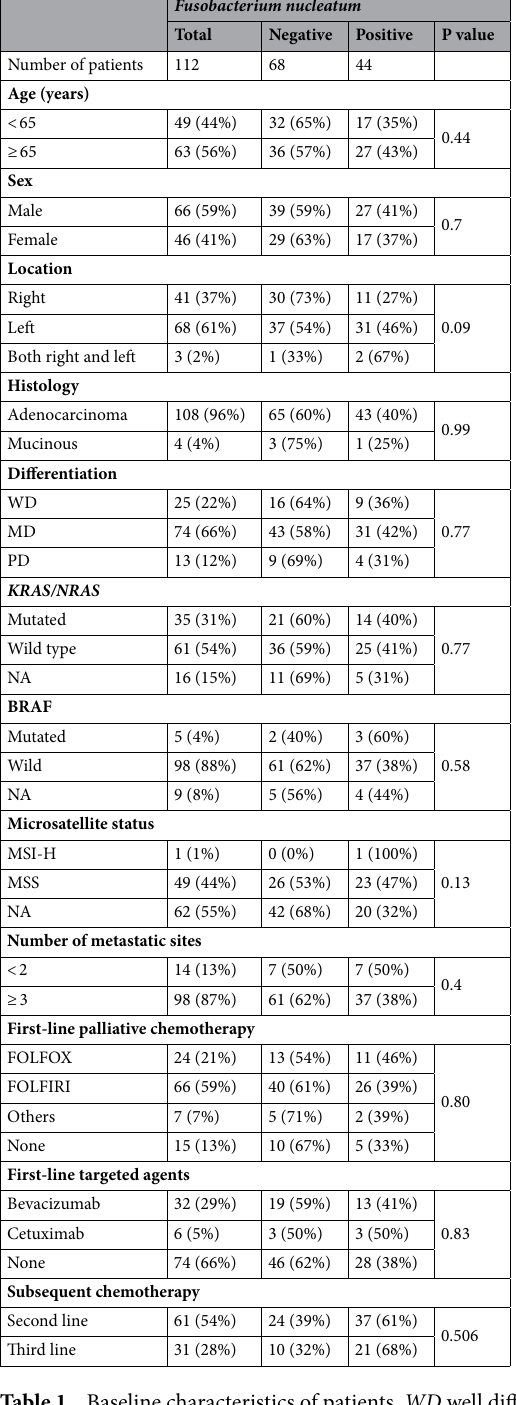
Table 1. Baseline characteristics of patients. WD well differentiated, MD moderately differentiated, PD poorly differentiated, MSI-H microsatellite instability-high, MSS microsatellite stable, FOLFOX bolus and infused fluorouracil with oxaliplatin, FOLFIRI bolus and infused fluorouracil with